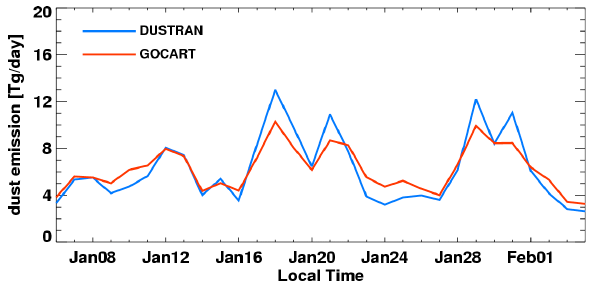
Figure 4 Daily total dust emissions from the DUSTRAN and GOCART schemes in 8 Fig. 4. Daily total dust emissions from the DUSTRAN and GO- Sect1-G and Sect1-D cases over North Africa for the simulation period. 9 CART schemes in Sect1-G and Sect1-D cases over North Africa for the simulation period.